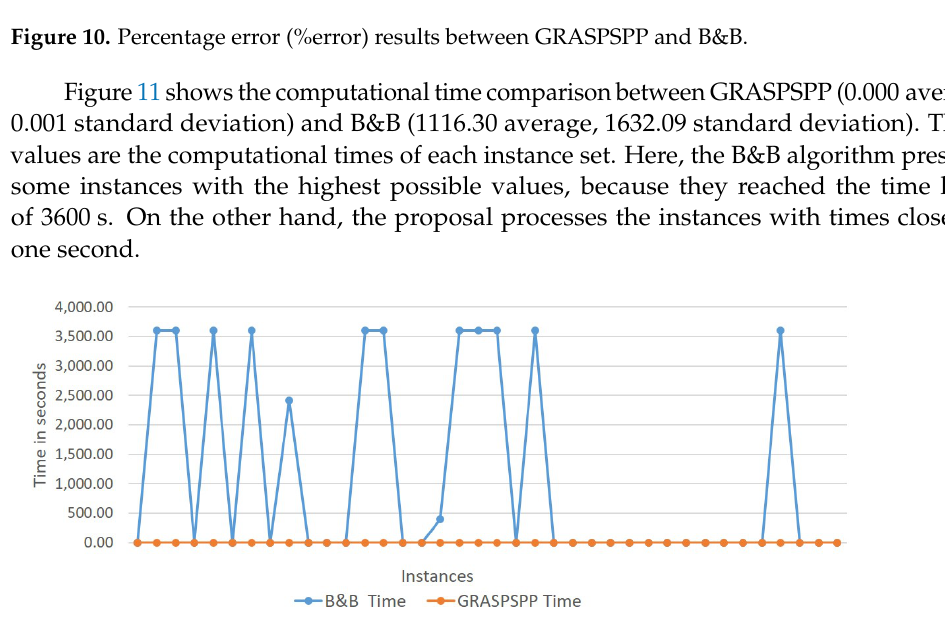
Figure 11. Time comparison between GRASPSPP and B&B